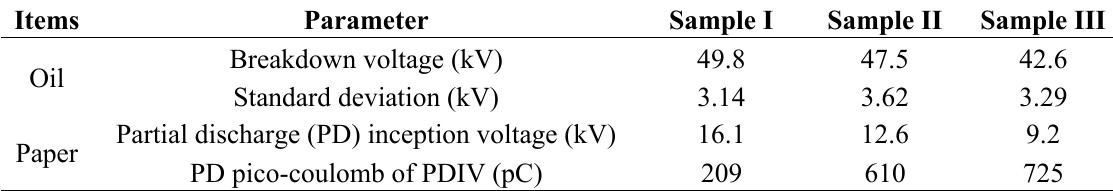
Table 3. Deposition effects on electrical strength of oils and paper-wrapped copper winding. PDIV: partial discharge inception voltages.